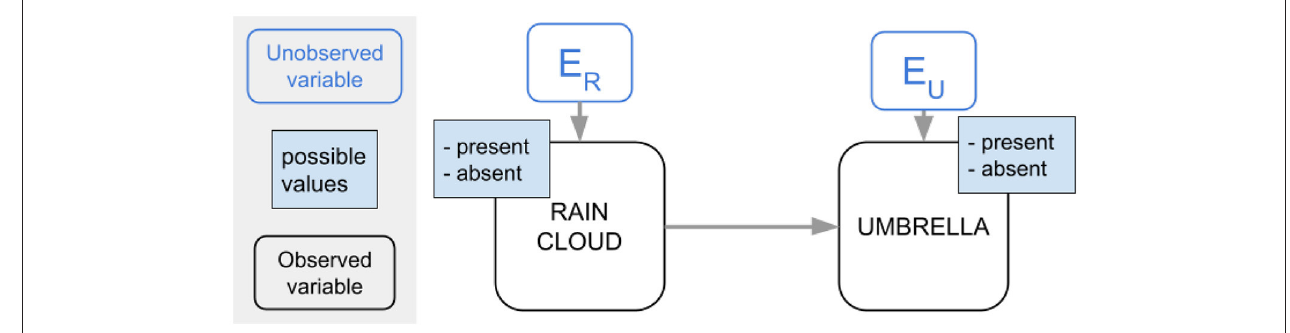
FIGURE 1 | Example